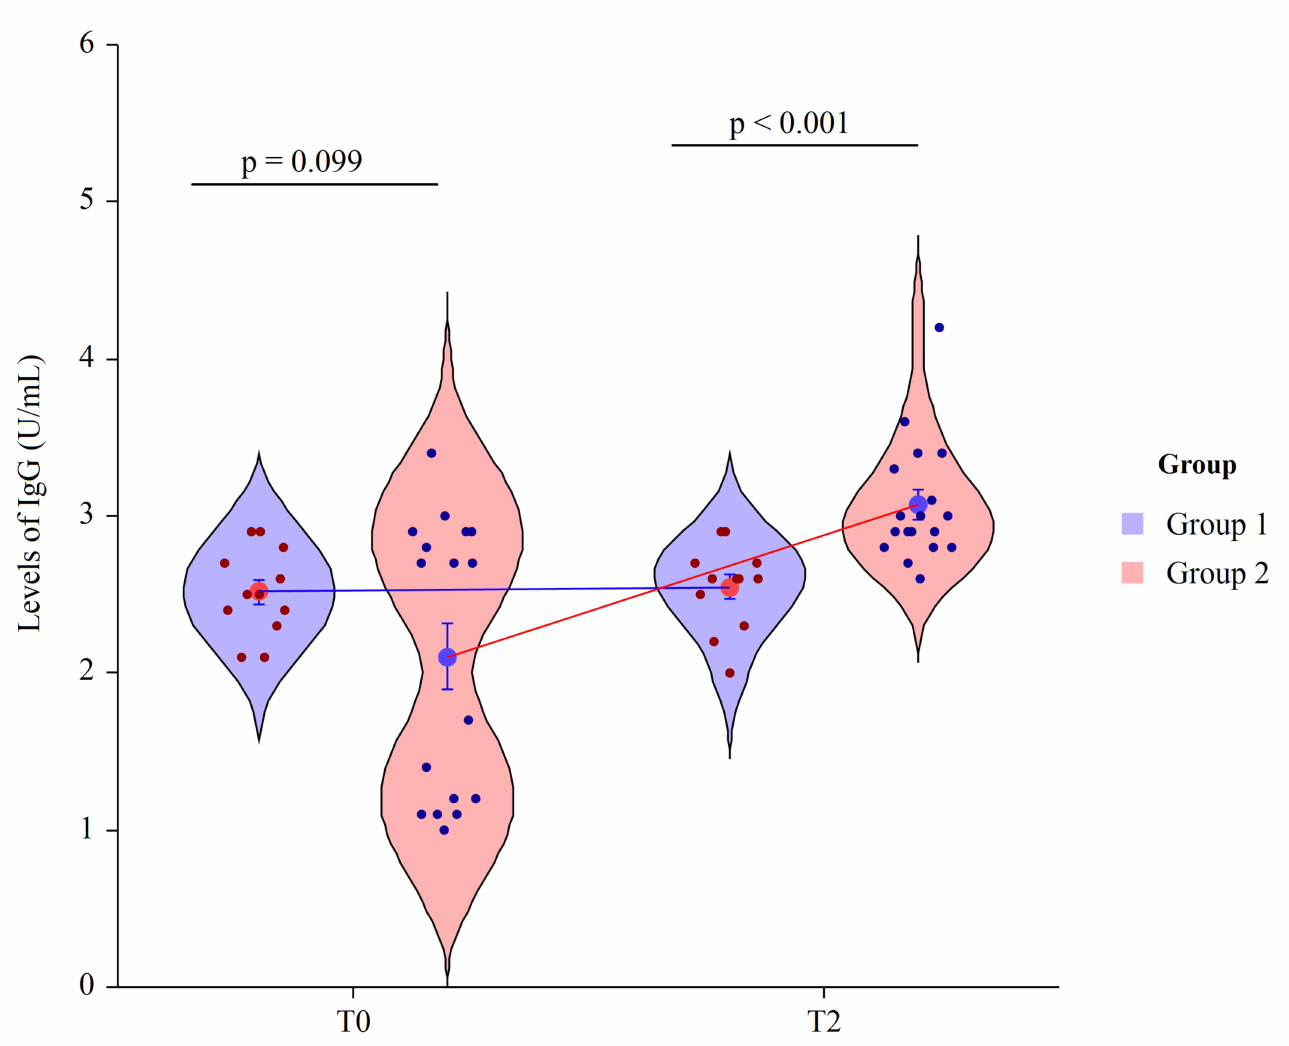
Figure 2. Two factor violin plots for IgG. Data, obtained by ELISA immunoassay, are shown as mean ± SE (standard error) at T0 (basal visit) and T2 (after eight weeks of supplementation and four weeks post-immunization) for both groups of patients. Dots represent the individual data and means are connected by lines. p -value derived from planned contrast on t